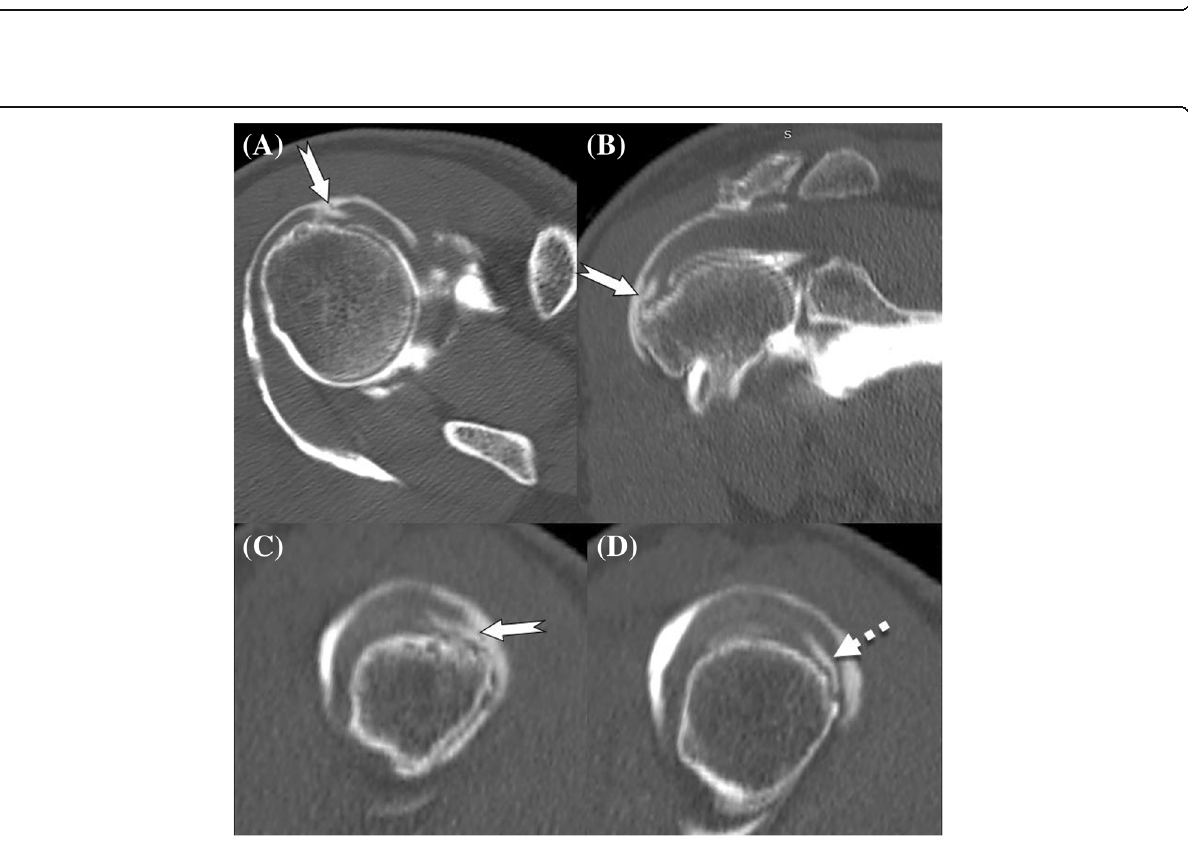
Fig. 5 Axial ( a ), coronal oblique ( b ), and sagittal oblique ( c , d ) CT arthrographic images in a 63 years old male complained from right shoulder pain especially on moving or lifting his arm, showing pure bursal surface defect (notched arrow) involving the anterior and distal fibers of the supraspinatus tendon with contrast leakage within its substance (dashed arrow). Note intact articular surface. Note that CTA alone could not be able to detect such a